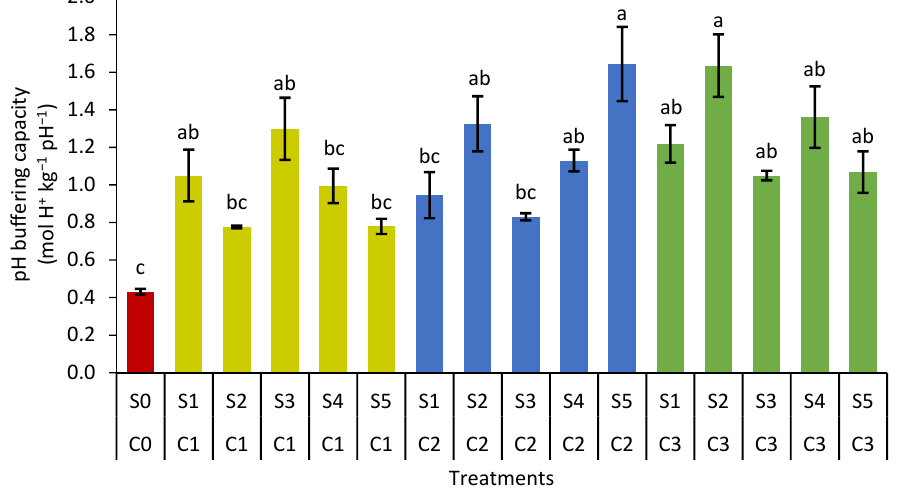
Figure 11. Soil pH buffering capacity for the different treatments after thirty days of leaching. Different letters indicate significant mean differences using Tukey’s HSD test at p ≤ 0.05. Error bars represent the standard error of the mean.